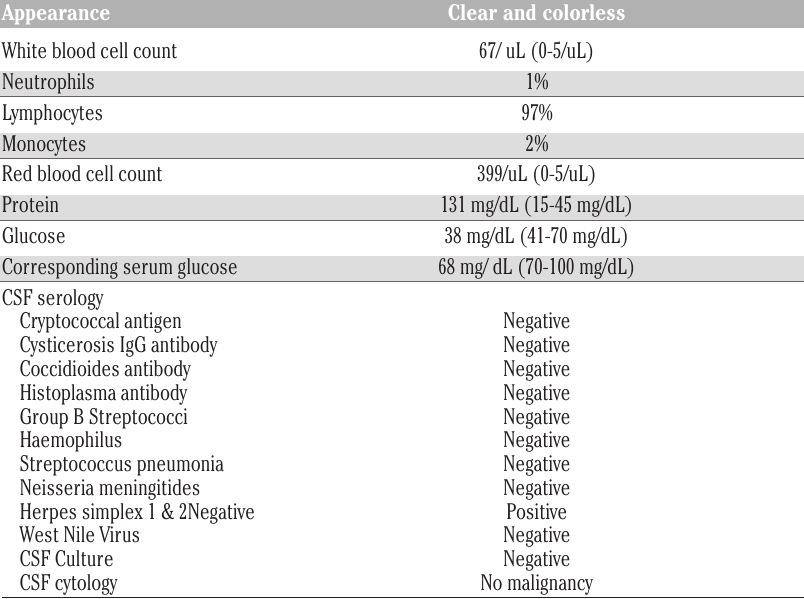
Table 2. Cerebrospinal fluid